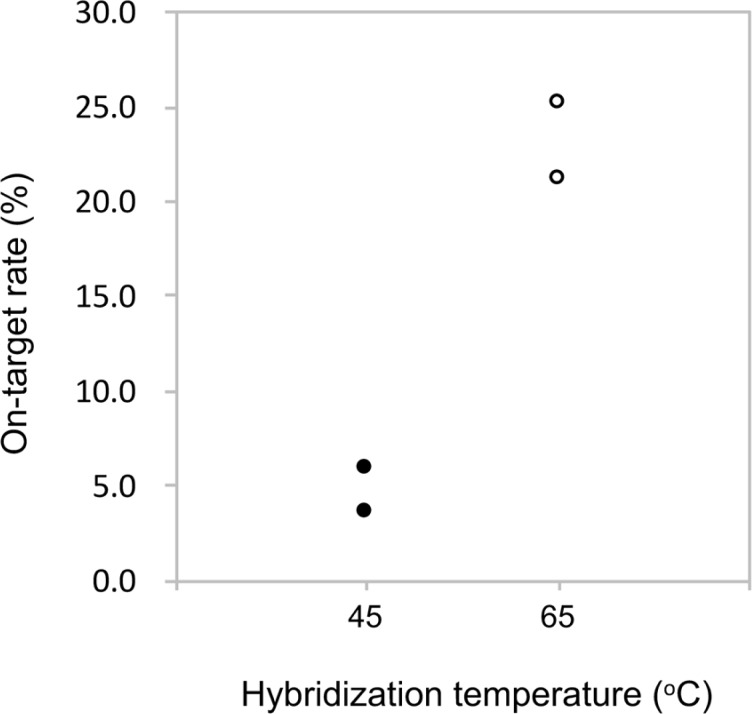
On-target rates of the hybridization temperature.The formula to calculate the on-target rate is the same as in Fig 3.